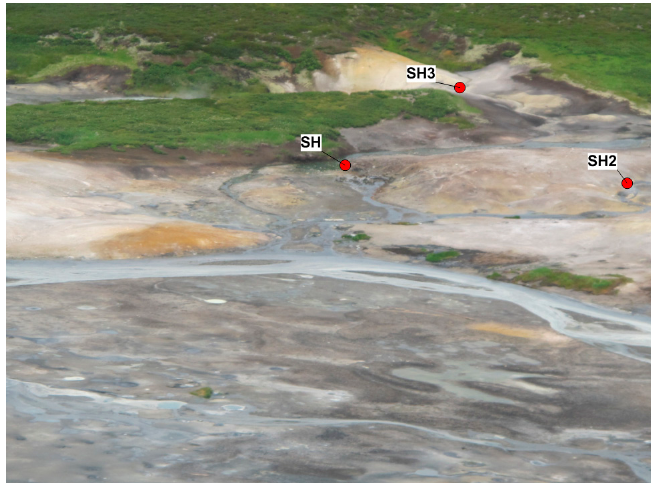
Figure A3. Shaman geyser area view, SH—Shaman geyser, SH2—adjacent CO 2 hot spring, SH3—hot spring in the upstream of creek, partially diverted into Shaman geyser conduit (photo by G. Karpov, 2015, northwest view). Geosciences 2019 , 9 , x FOR PEER REVIEW 14 of 23